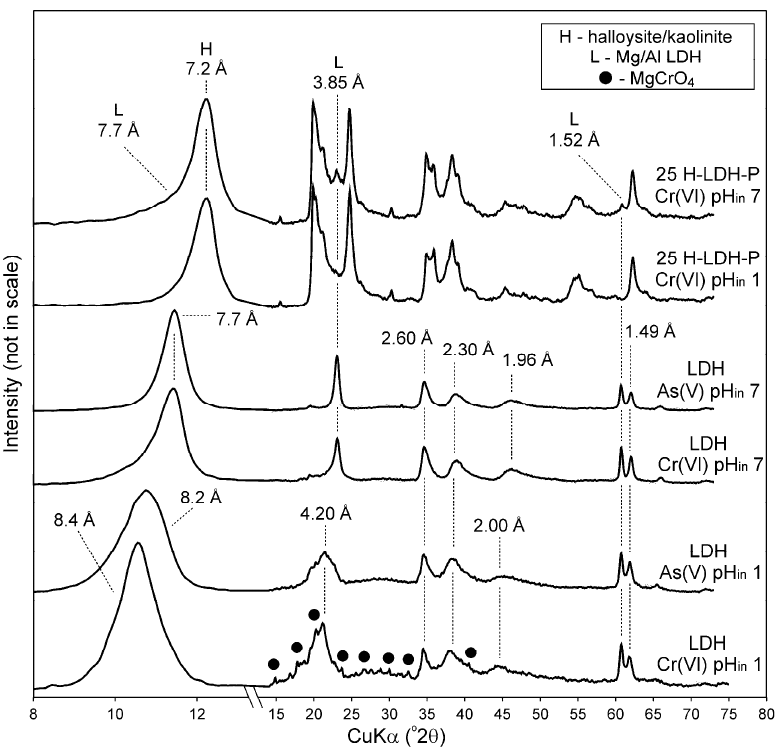
Figure 7. XRD pattern of selected samples after reaction with As(V) and Cr(VI).